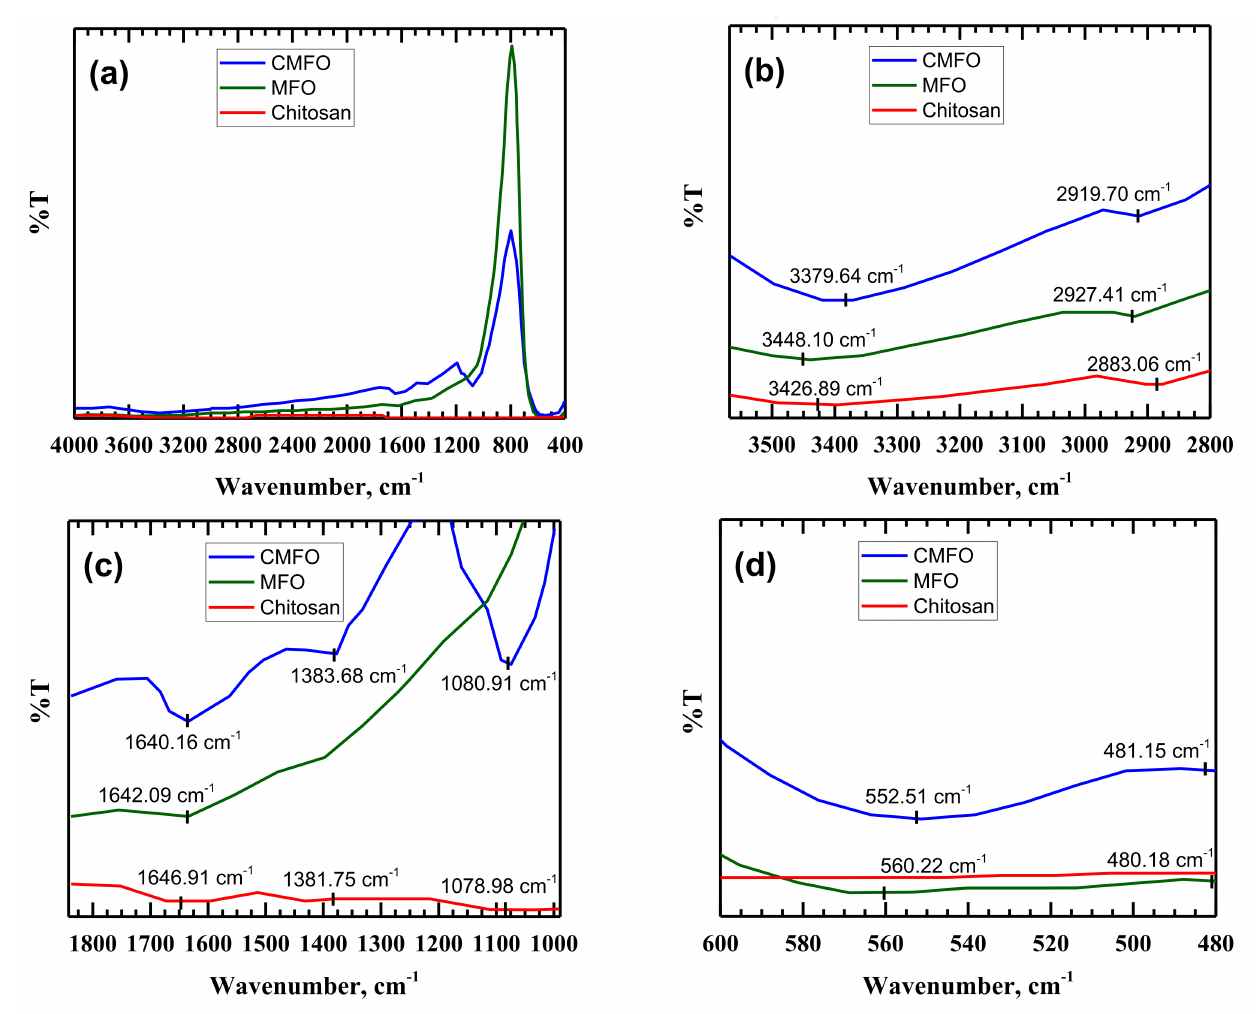
Figure 2. FTIR spectra of CMFO, MFO, and pure chitosan at ( a ) 400 to 4000 cm − 1 , ( b ) 2800 to 3575 cm − 1 , ( c ) 1000 to 1825 cm − 1 , and ( d ) 480 to 600 cm − 1